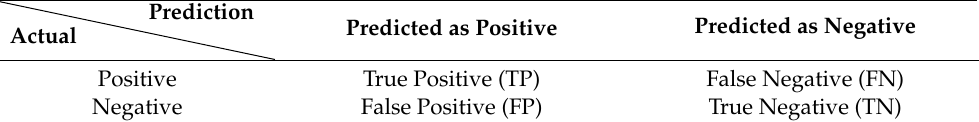
Table 3. Confusion matrix